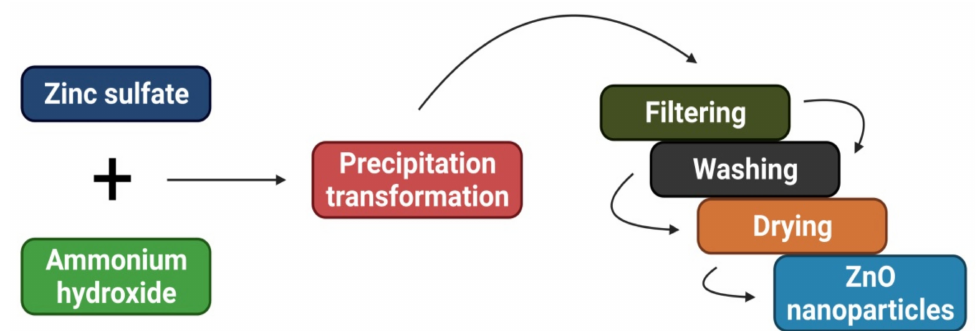
Figure 5. Diagrammatic representation of the stages required for ZnO-NPs synthesis employing the co-precipitation